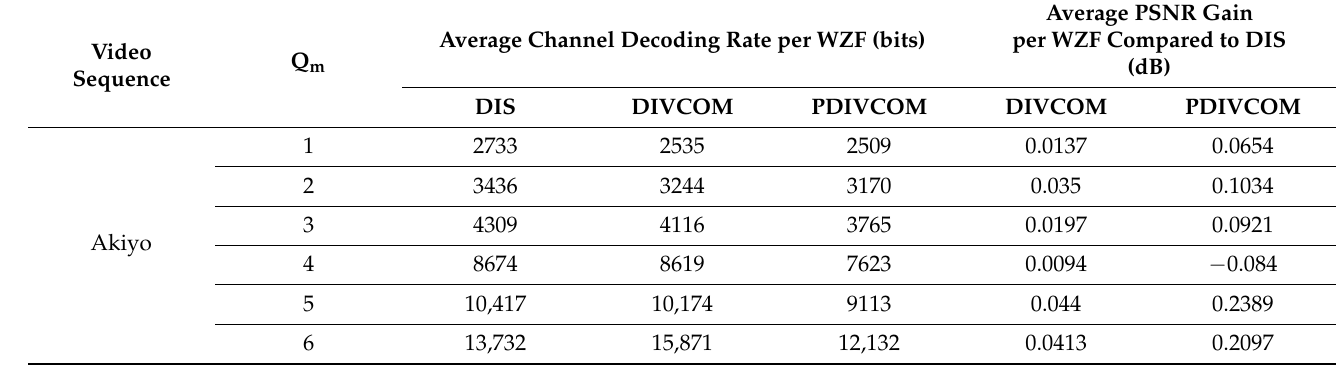
Table 5. Coding efficiency evaluation of proposed novel online CNM for “Akiyo” video